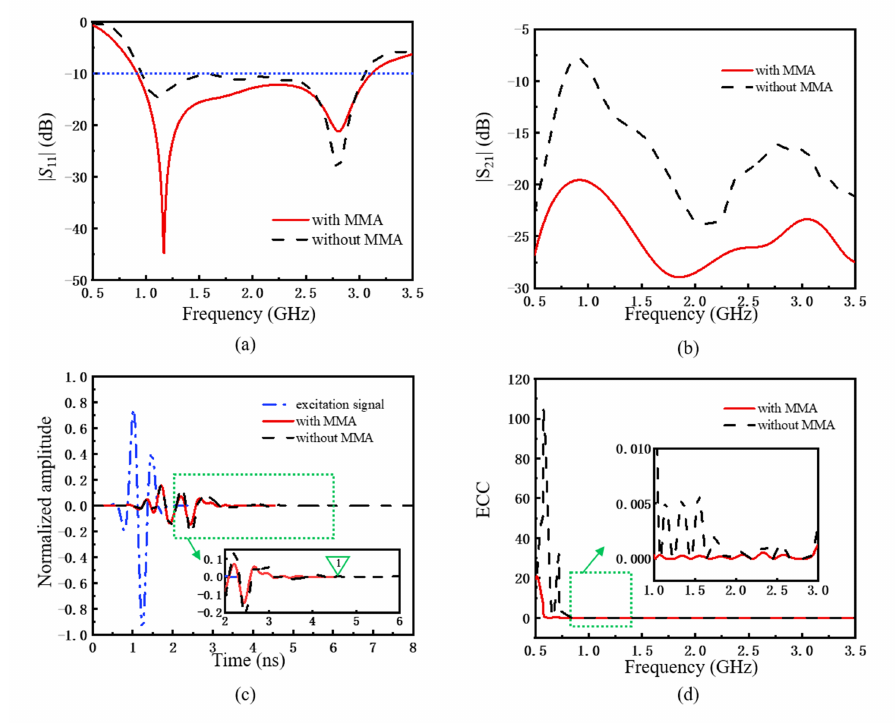
Figure 3. ( a ) | S 11 | and ( b ) | S 21 | of the transceiver antenna with and without MMA. ( c ) Time domain response of the transceiver antenna. ( d ) The ECC of the transceiver